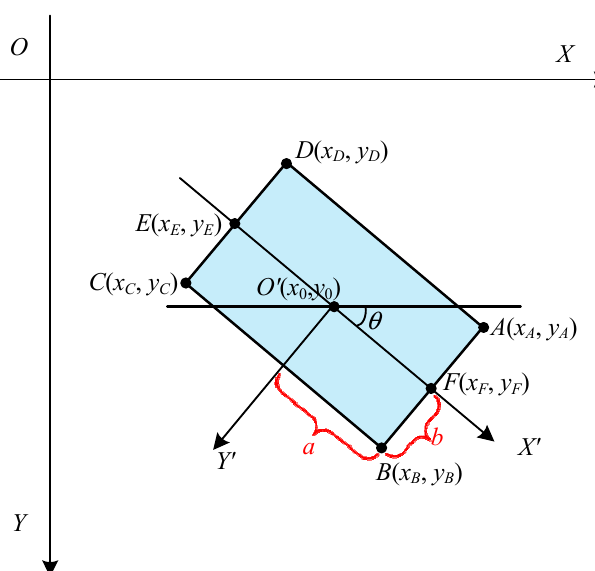
Figure 5. A schematic diagram of calculating the ground truth.